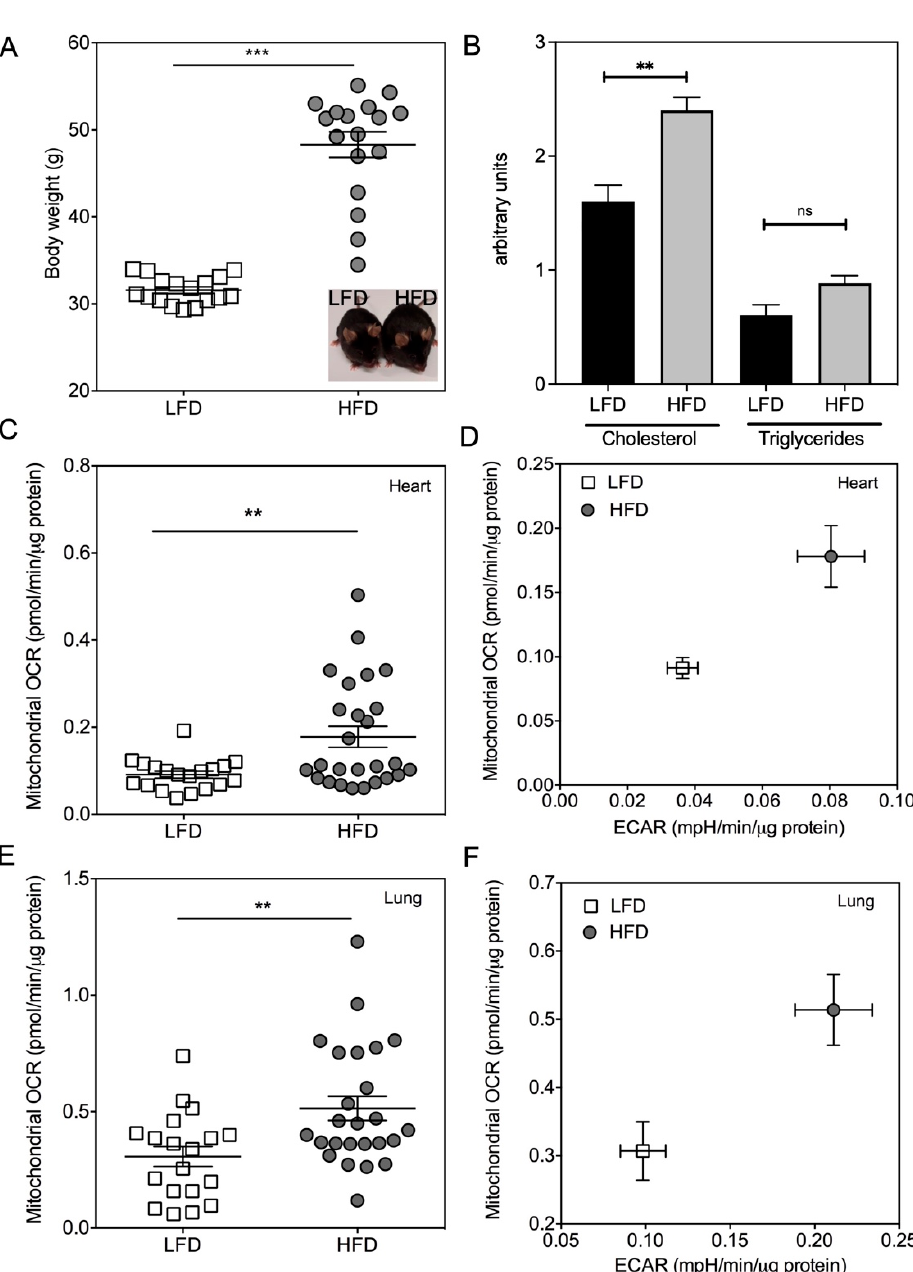
Figure 4. Impact of high-fat diet (HFD) feeding on oxygen consumption in cardiac and lung samples. ( A ) Sixteen weeks of high-fat diet (HFD) induced a significant increase in body weight compared to low-fat diet (LFD). ( B ) Quantification of cholesterol and triglycerides in plasma of LFD and HFD mice. ( C , E ) Mitochondrial oxygen consumption rate (basal OCR—non mitochondrial OCR) and ( D , F ) extracellular acidification rate (basal ECAR) have been assessed from biopsies of at least 20 mice for each diet in heart and lung samples. Graphs showed the individual and mean values. Significant p values are indicated, ** p <0.01. *** p < 0.001.